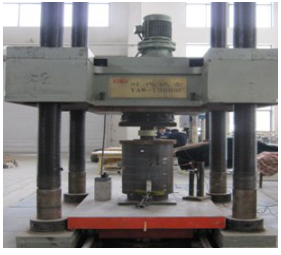
Figure 2. Specimens.